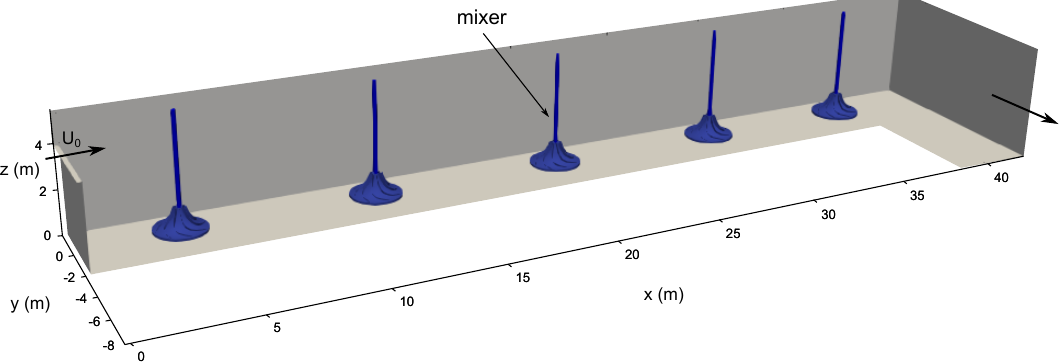
Figure 4. 3D model of the anoxic section of the full scale HRAS system at the water resource recovery facility (WRRF) Nieuwveer (Breda,